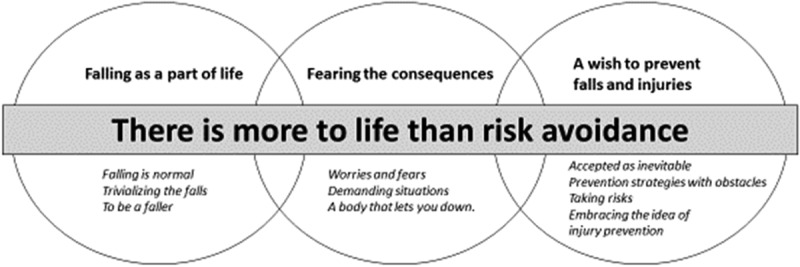
Theoretical model.